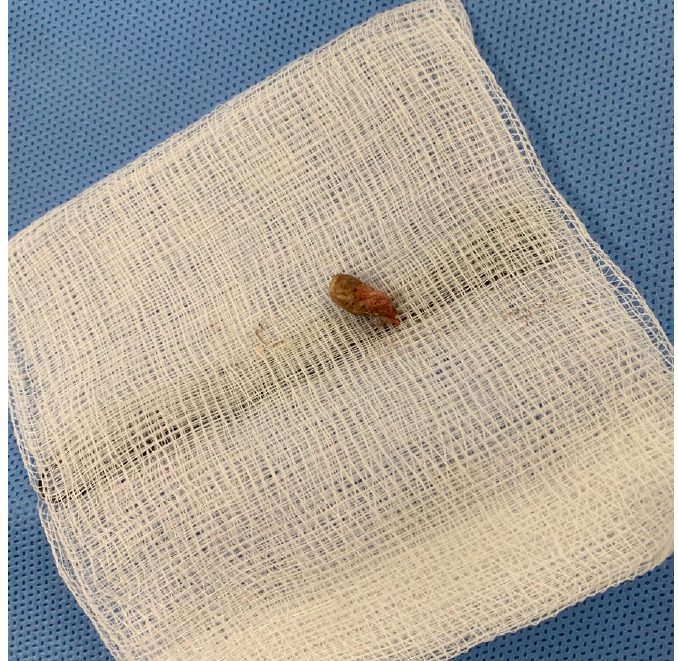
Figure 2. Foreign body found in the left ear approximately 1 cm × 0.5 cm × 0.5 cm on gauze. Firm to touch with fibrous